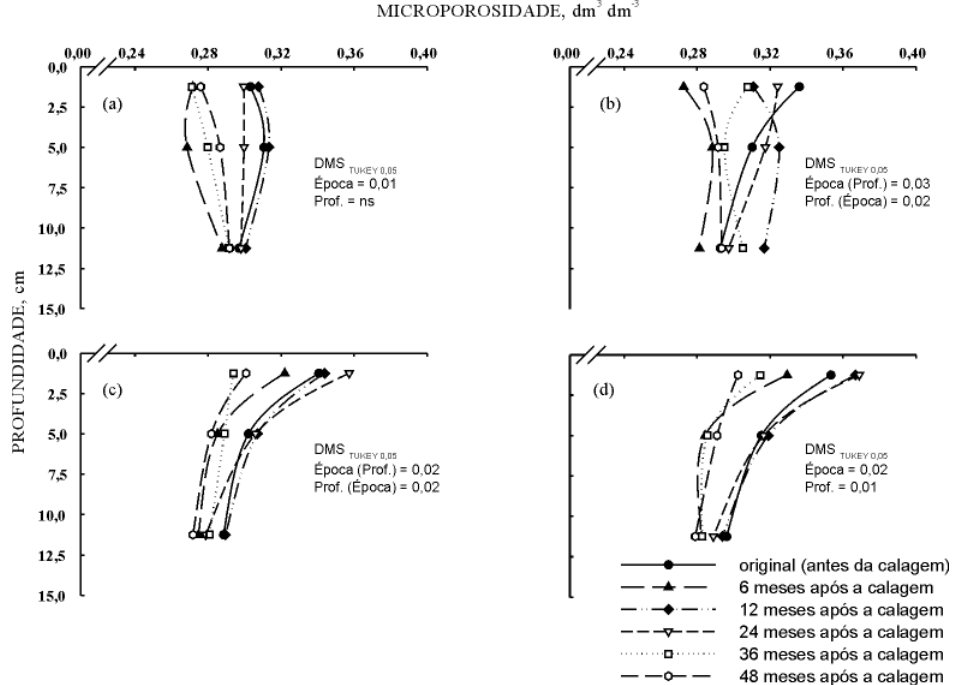
Figura 4. Microporosidade do solo em diferentes épocas de avaliação, profundidades e sistemas de manejo. (a) convencional durante 12 anos; (b) semeadura direta com revolvimento do solo a cada quatro anos; (c) semeadura direta durante oito anos; (d) semeadura direta duante 12